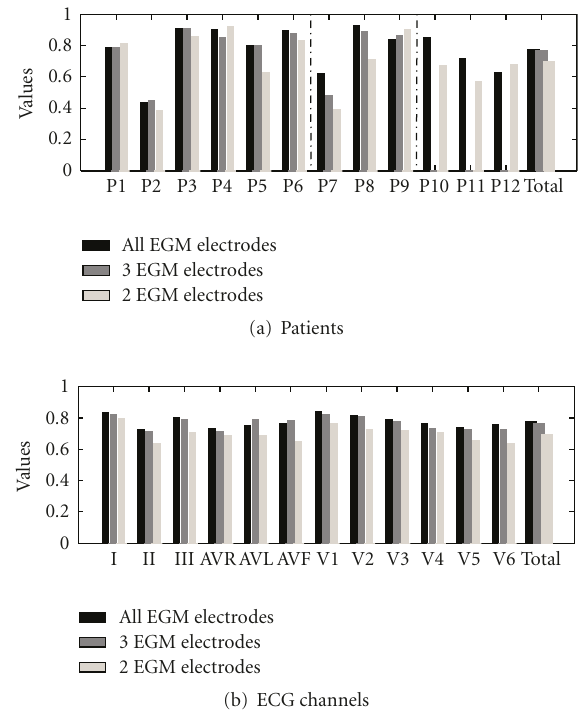
Figure 16: The correlation coe ffi cient between ECG and ECGR using all EGM channels (black bars), using three EGM channels (dark gray bar) and using two EGM channel (light gray bar): (a) for each patient and (b) for each